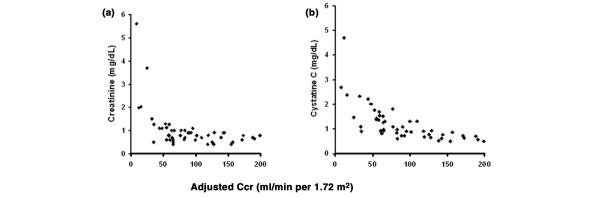
Relationships of (a) serum creatinine and (b) serum cystatin C to creatinine clearance (CCr).